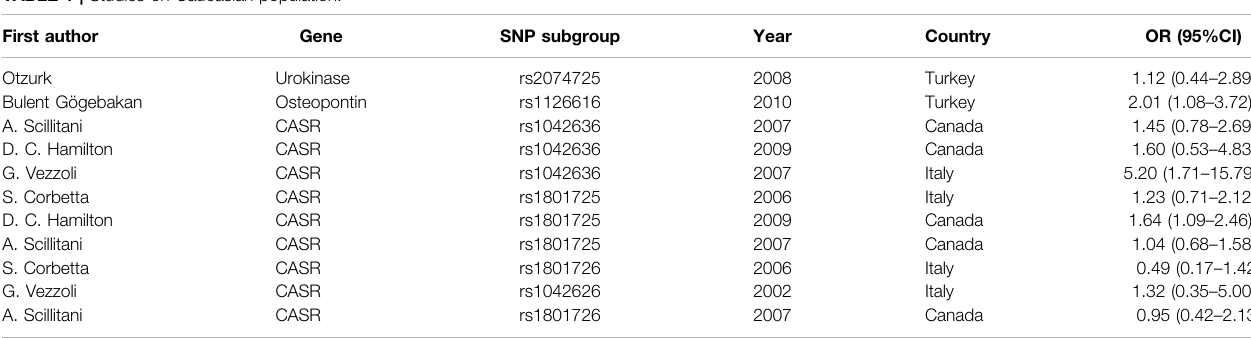
TABLE 1 | Studies on Caucasian